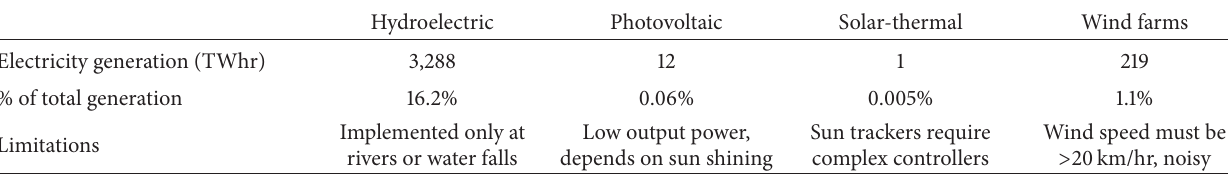
Table 2: Comparison of different renewable power plants